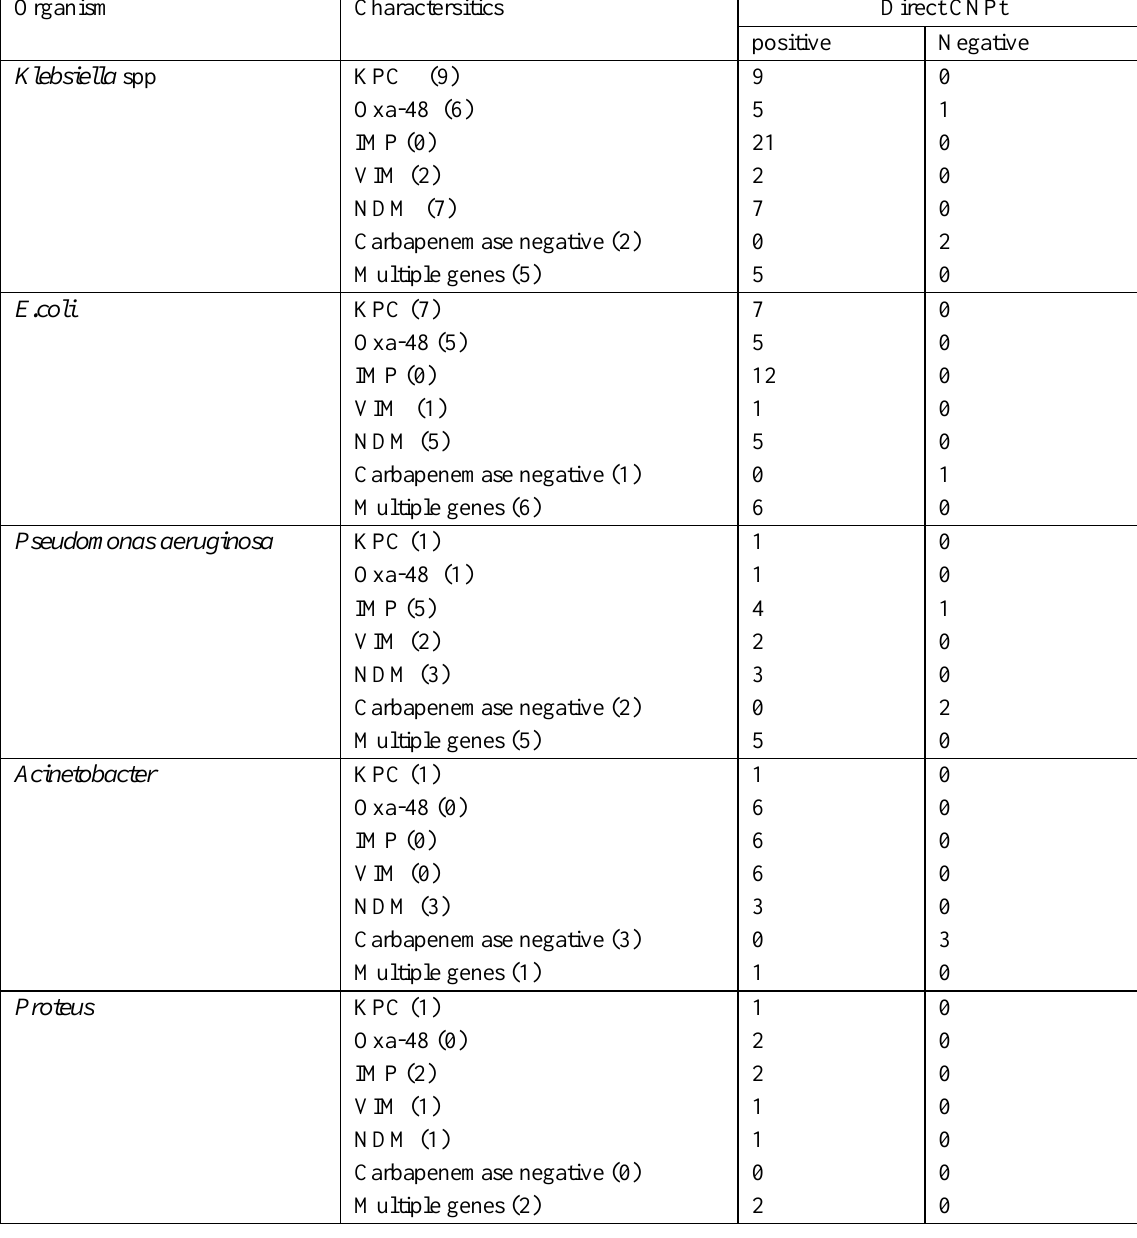
Table 3. Results of direct CNPt for detection of carbapenemases in tested isolates. Organism